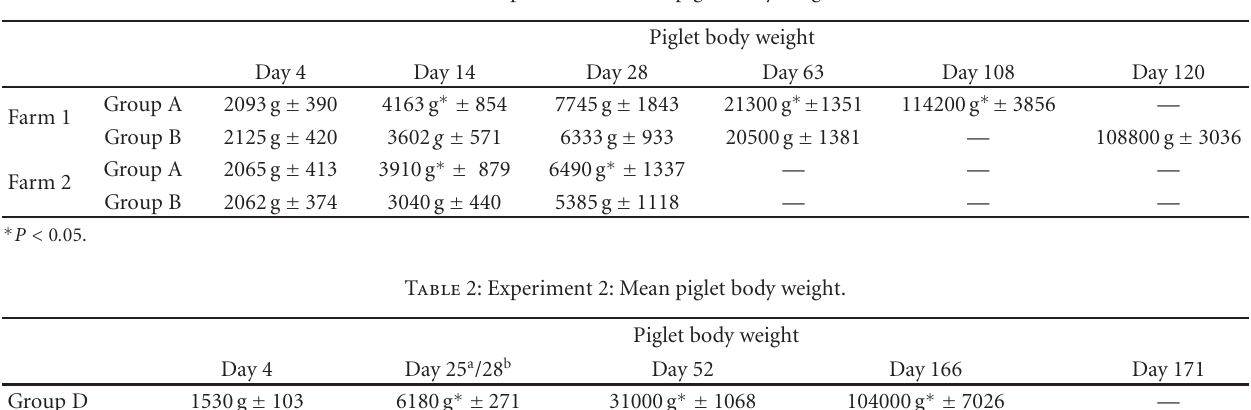
Table 1: Experiment 1: Mean piglet body weight.